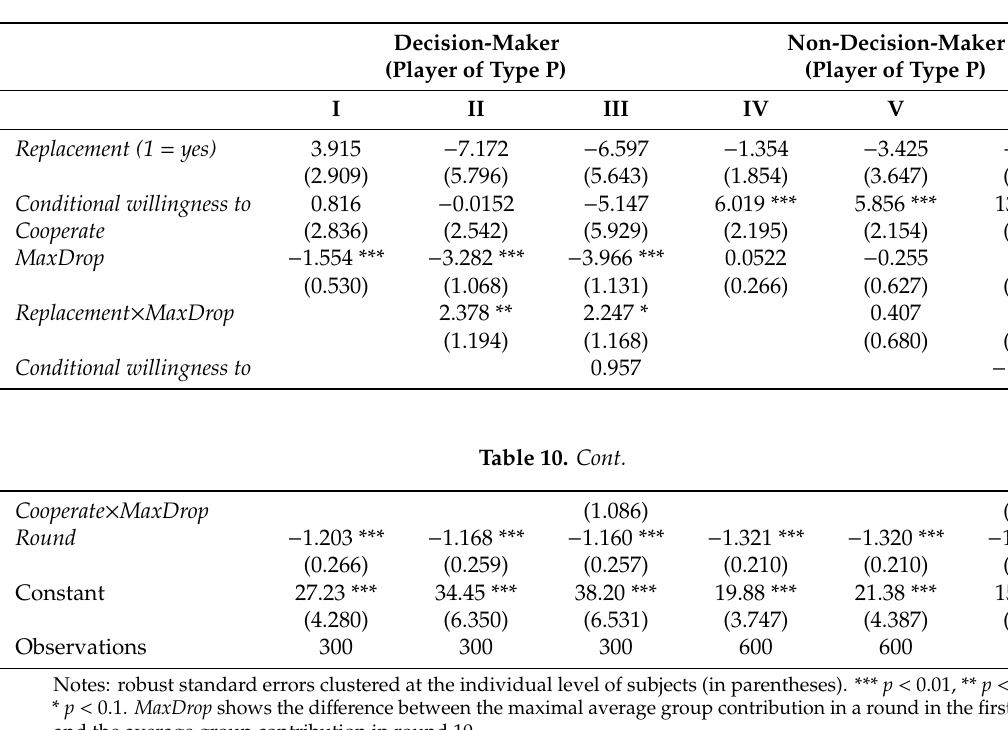
Table 10. Tobit estimations on individual contributions in part II in Endo (player of type P: decision vs. non-decision-maker)